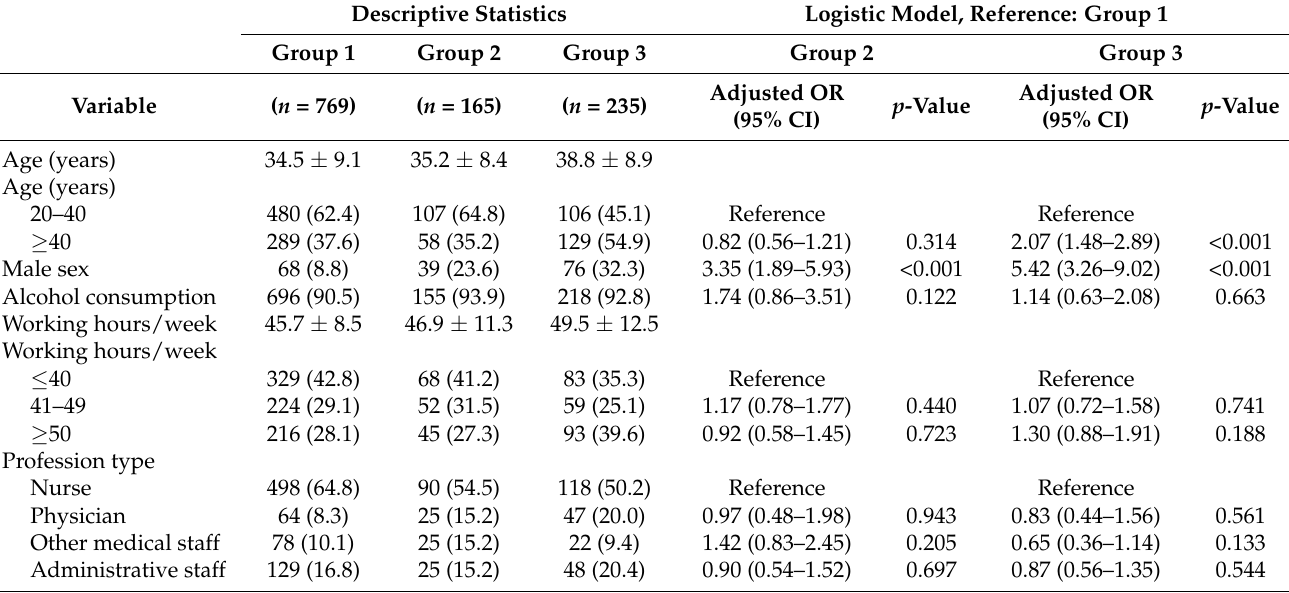
Table 4. Basic demographics of the study population according to the latent classes of developmental trajectories for MUOO in the longitudinal